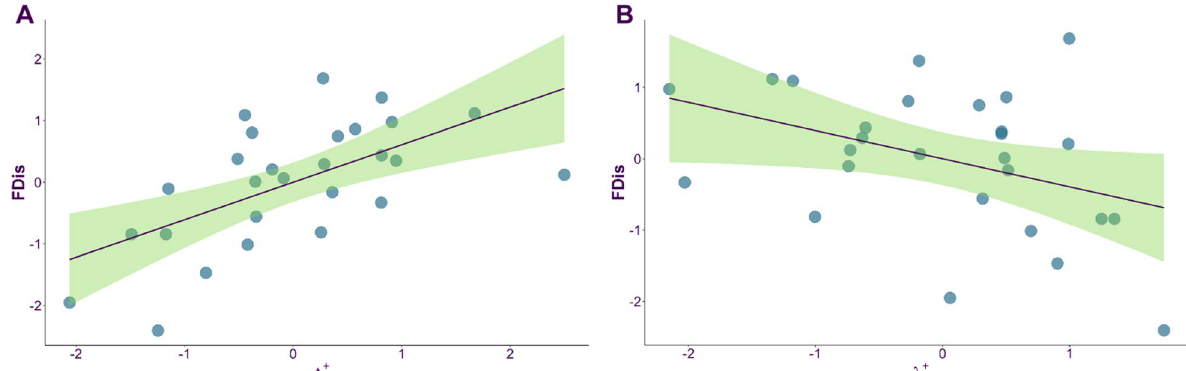
Fig. 4 Scatter plots of the relationship between A functional dispersion (FDis) and taxonomic distinctness (Δ + ) (multiple R 2 functional dispersion (FDis) and the index of variation in taxonomic distinctness (λ + ) (multiple R 2 sites studied along the Ganga River